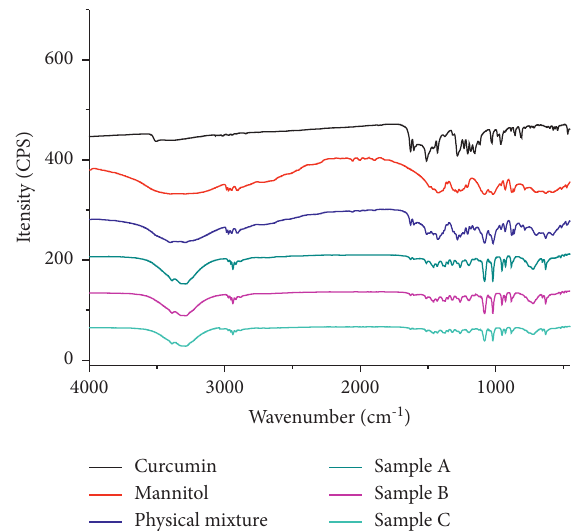
Figure 6: FTIR spectra of the raw materials, physical mixture, and samples.